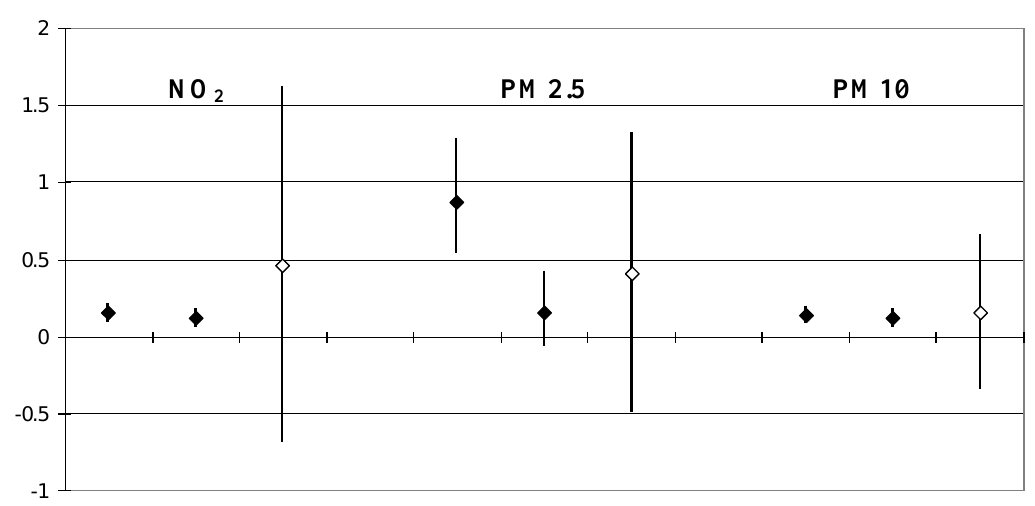
Figure 2. Effect estimates in Linz 2000–2007: Per cent change in daily mortality, with 95% confidence interval, per 10 µg/m³ increase in the respective pollutant measure. Full diamonds: Estimates from the years 2000–2007 on the same and on preceding day (lag 0 and lag 1), case-crossover model for the summer season (1st June to 31st August). For comparison Poisson GAM (open diamonds): estimates from the years 1990–2007 (full years) for the average of the same and preceding day (lag 0–1).